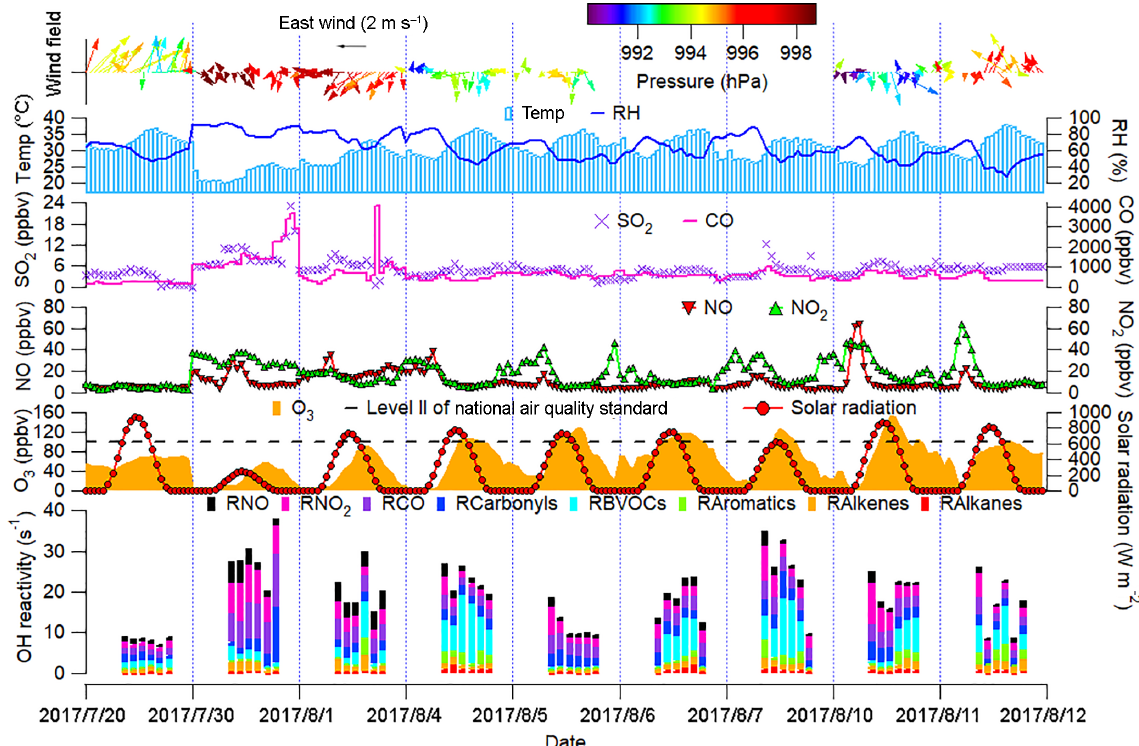
Figure 2. Time series of trace gases, OH reactivity of O 3 precursors and meteorological parameters. Wind speed and wind direction were not monitored from 17:00LT on 5 August to 23:00LT on 7 August due to malfunction of the weather station. RH in the top panel denotes the relative humidity. R X in the bottom panel is the OH reactivity of species/group X